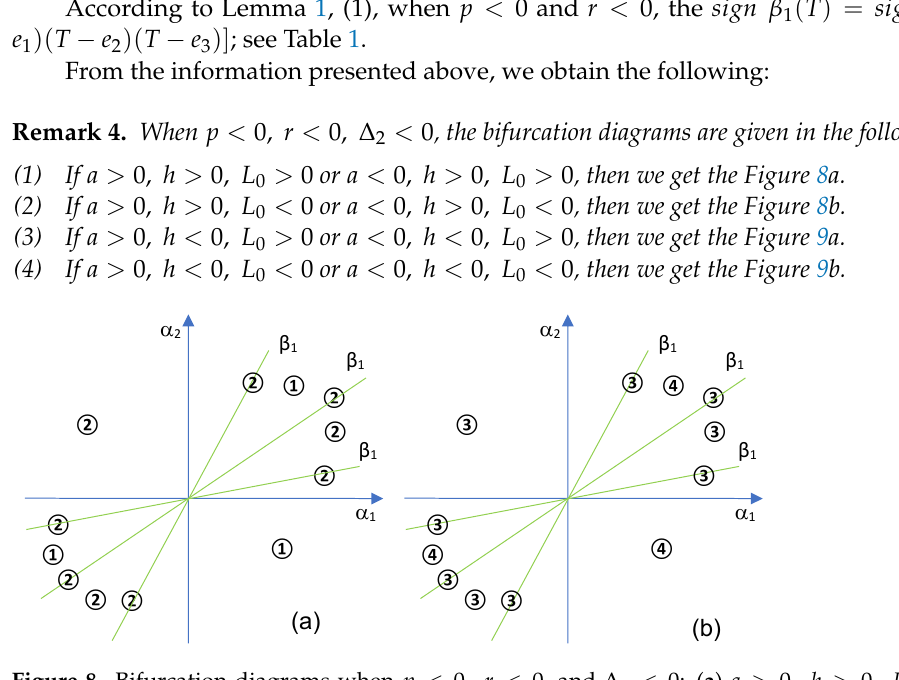
Figure 8. Bifurcation diagrams when p < 0, r < 0, and ∆ 2 < 0: ( a ) a > 0, h > 0, L 0 > 0 or